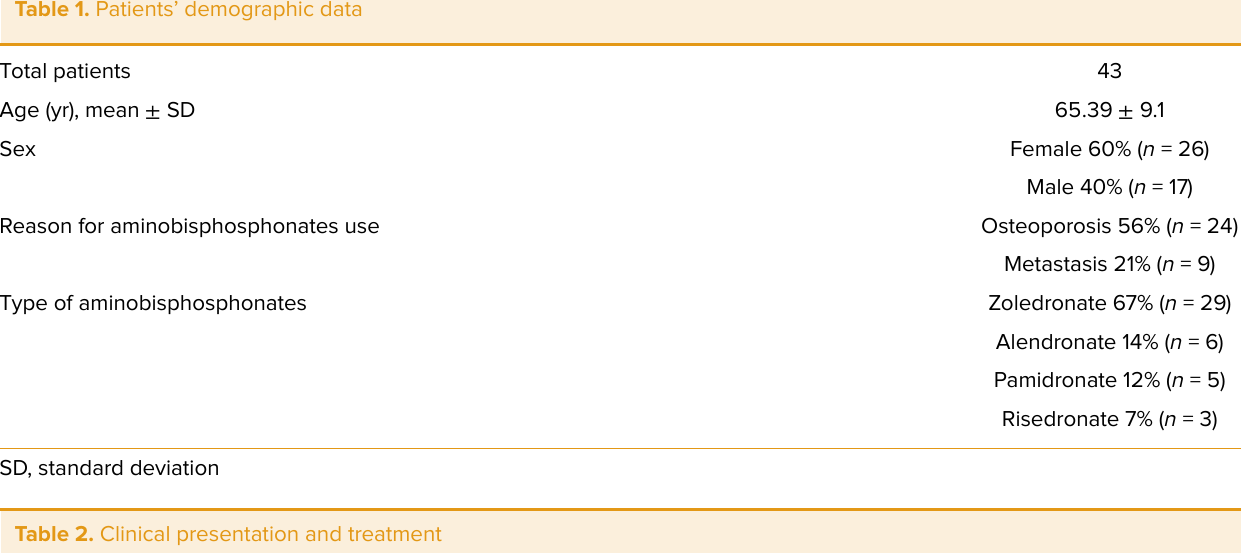
Table 1. Patients’ demographic data